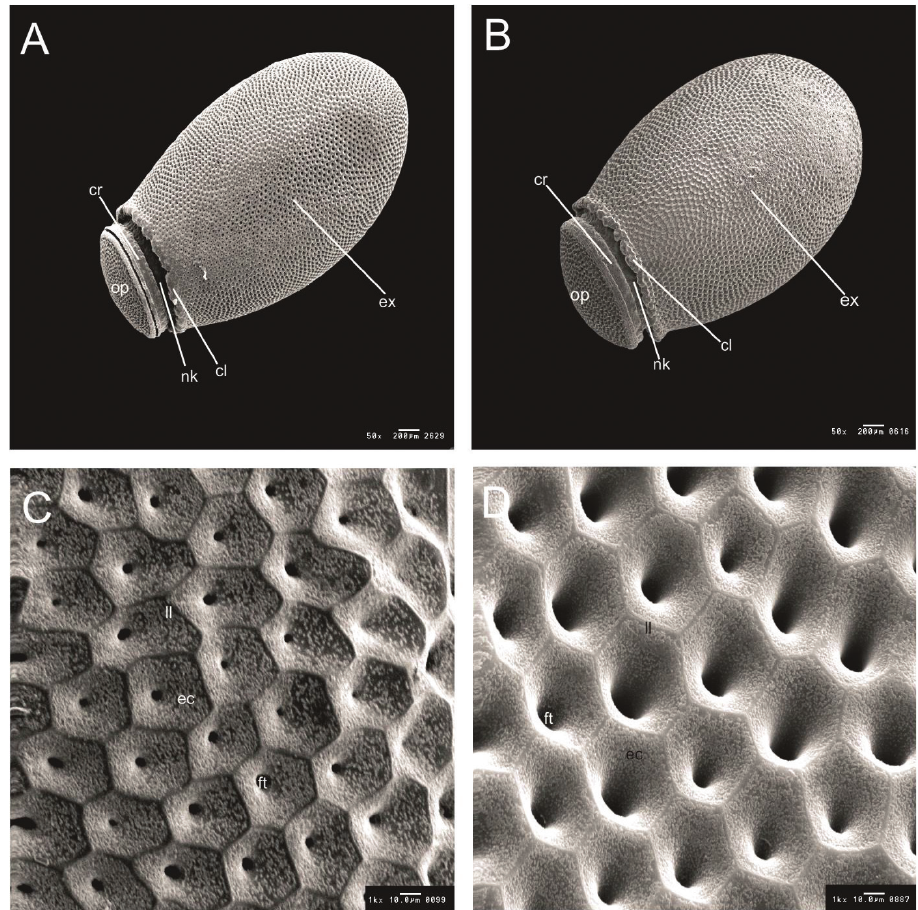
Figure 7. Eggs general vision and egg exochorium detail of R. taquarussuensis sp. n. ( A, C ), R. neglectus ( B, D ). cl: colar, cr: chorial rim, ex: exochorium, nk: neck, op: operculum, ec: exochorium cell, ft: fol- licular tubes, ll: limiting